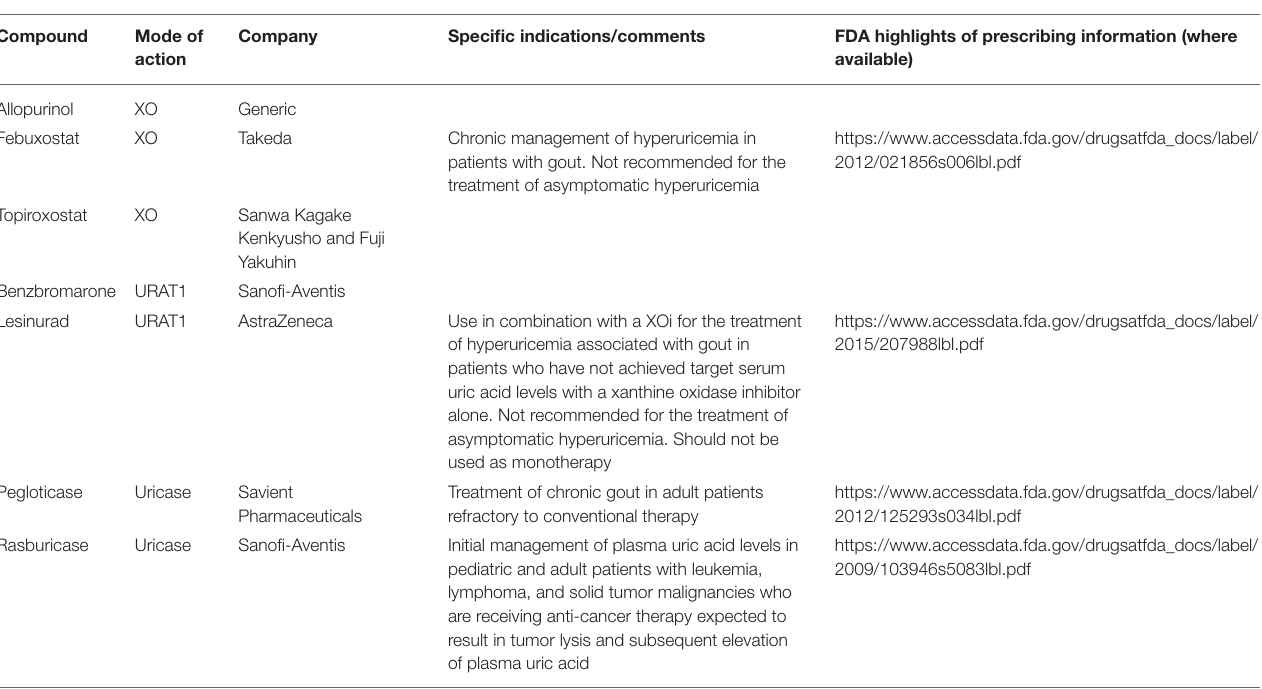
TABLE 2 | Launched (marketed and withdrawn) therapies for hyperuricemia/gout.